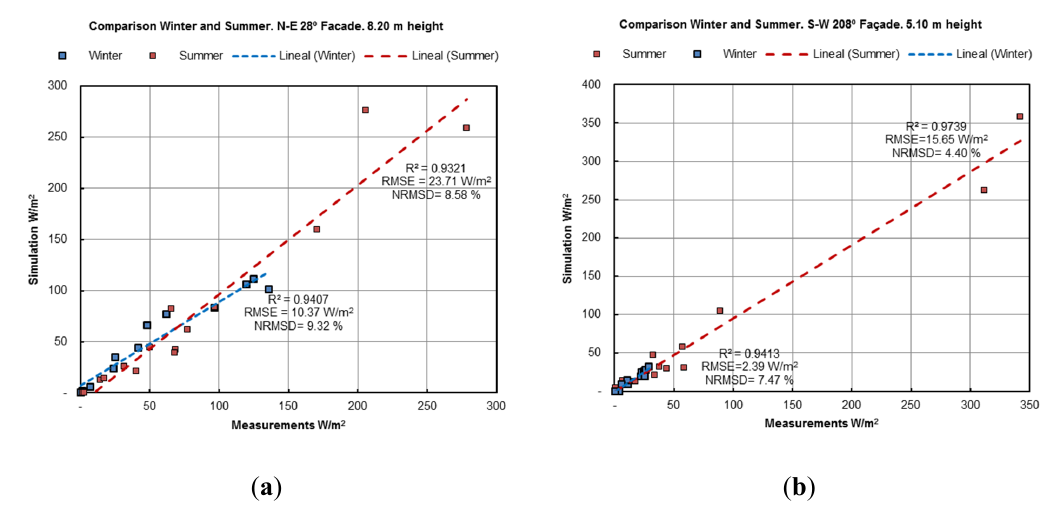
Figure 8. 24 h comparison between cell measurements and simulations, summer in Cadiz. ( a ) N-E 28º Façade; ( b ) S-W 208º Façade. Energies 2015 , 8